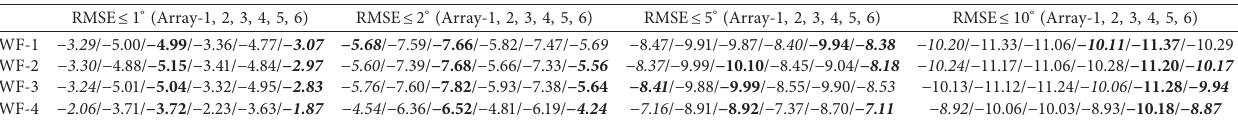
Table 4: SNR (dB) values when arrays can produce 50% correct results using 513 snapshots under different estimation accuracies. RMSE ≤ 1 ° (Array-1, 2, 3, 4, 5, 6) RMSE ≤ 2 ° (Array-1, 2, 3, 4, 5, 6) RMSE ≤ 5 ° (Array-1, 2, 3, 4, 5, 6) RMSE ≤ 10 ° (Array-1, 2, 3, 4, 5, 6)